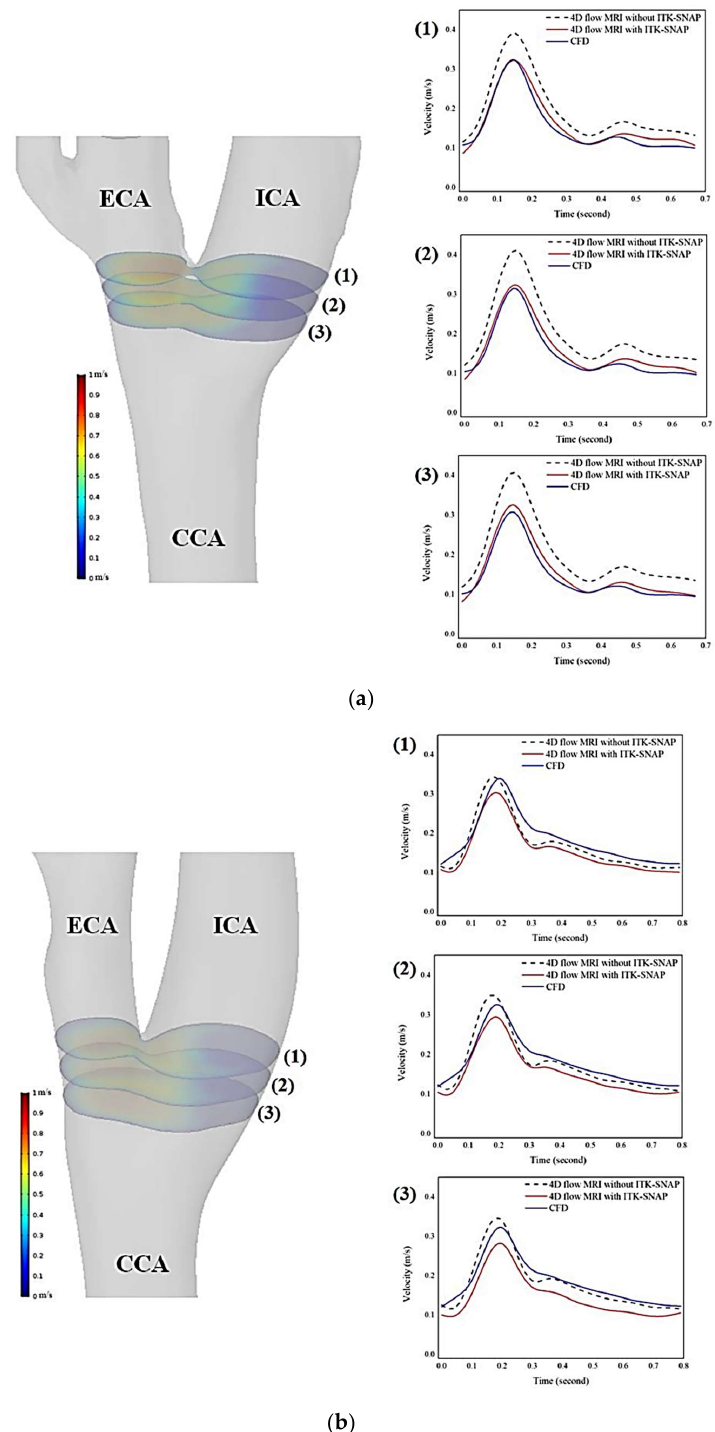
Figure 3. ( a ) Three analysis planes of left carotid artery from subject 1 ( left panel ). The velocity waveforms at the bifurcation planes provided by 4D flow MRI without ITK-SNAP (dashed line), 4D flow MRI with ITK-SNAP (red line), and CFD (blue line). Results from 4D flow MRI with ITK-SNAP and CFD revealed a close similarity of shape. ( b ) Three analysis planes of left carotid from subject 5 ( left panel ). The velocity waveforms at the bifurcation planes provided by 4D flow MRI without ITK-SNAP (dashed line), 4D flow MRI with ITK-SNAP (red line), and CFD (blue line). The velocity waveforms were variable among the 3 approaches.